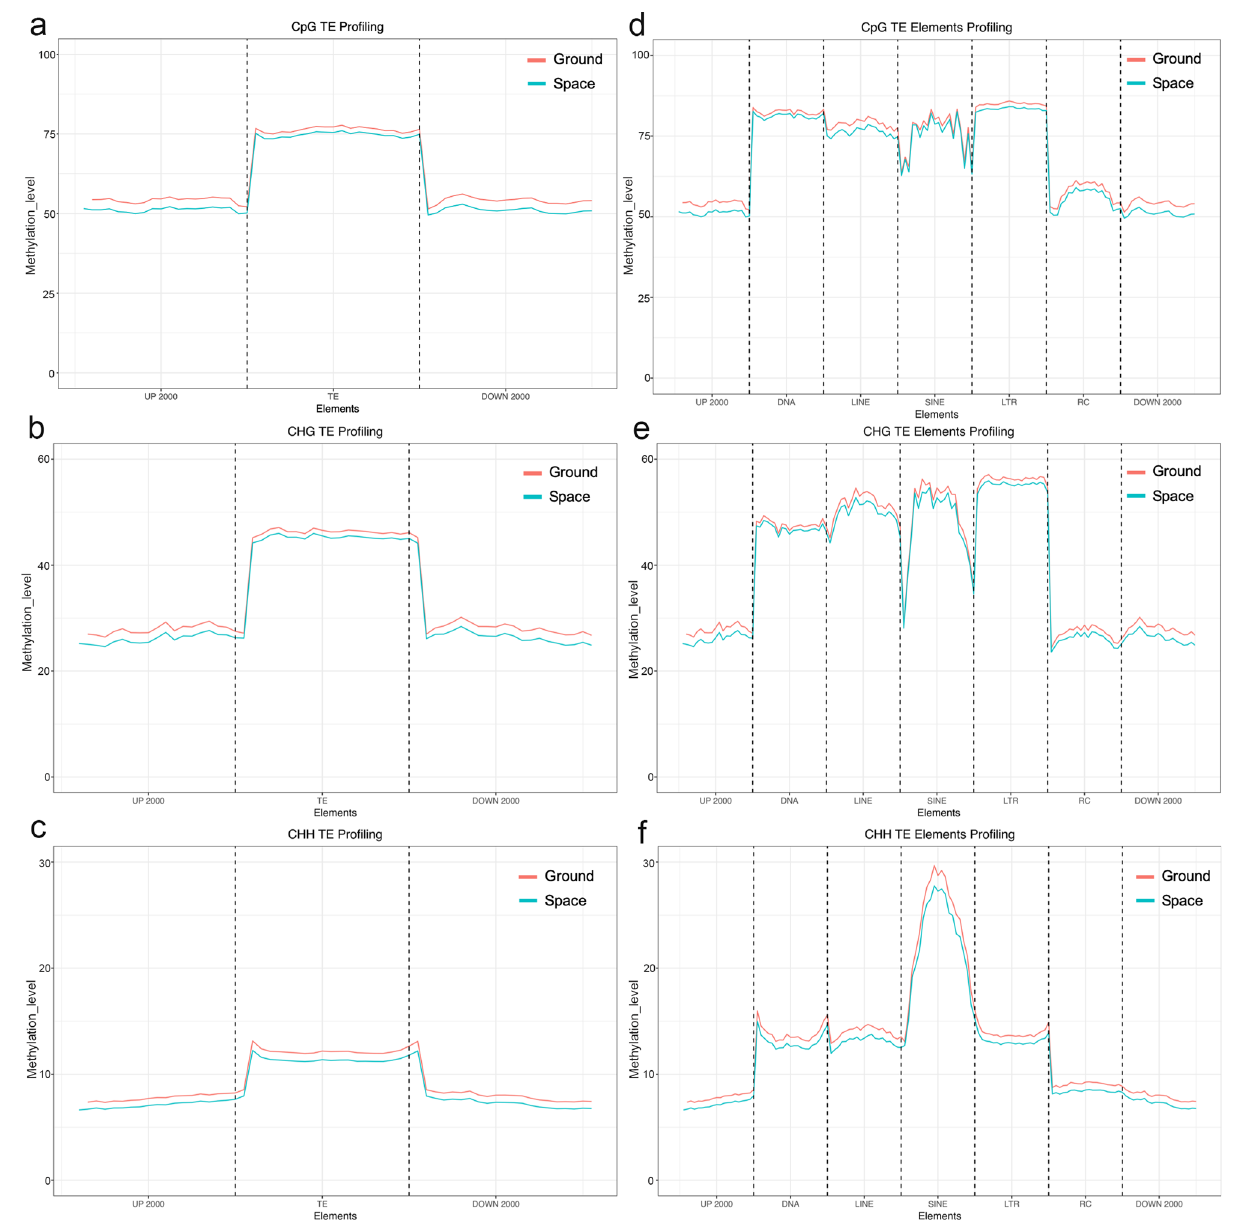
Fig. 6 Methylation patterns of different types of transposable elements (TEs) in the Arabidopsis genome of the F 1 generation of the space fl ight and ground control samples. a – c Methylation pattern of TEs. The fi gure shows the methylated density distribution of the Arabidopsis genome of all TEs in a CpG, b CHH, and c CHG in the F 1 generation ground control and space fl ight samples. The x -axis represents the TE body and its 2-kb upstream or downstream regions. The y -axis is the average methylation level. d – f This study showed the methylation patterns of TEs of fi ve different types, namely DNA, long interspersed nuclear elements (LINE), short interspersed nuclear elements (SINE), long terminal repeats (LTR), and rolling-circle (RC) TEs in the F 1 generation from ground control and space fl ight